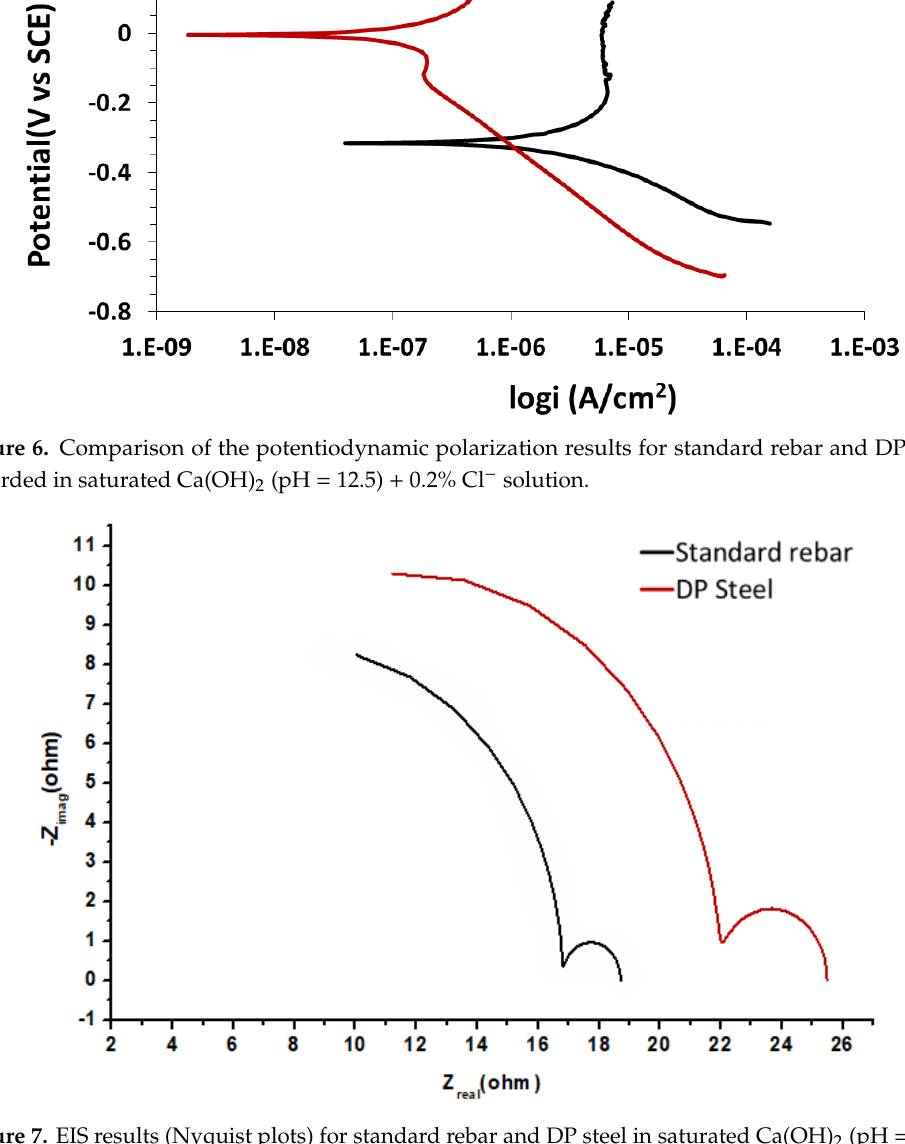
Figure 7. EIS results (Nyquist plots) for standard rebar and DP steel in saturated Ca(OH) 2 (pH = 12.5) + 0.2% Cl − solution.